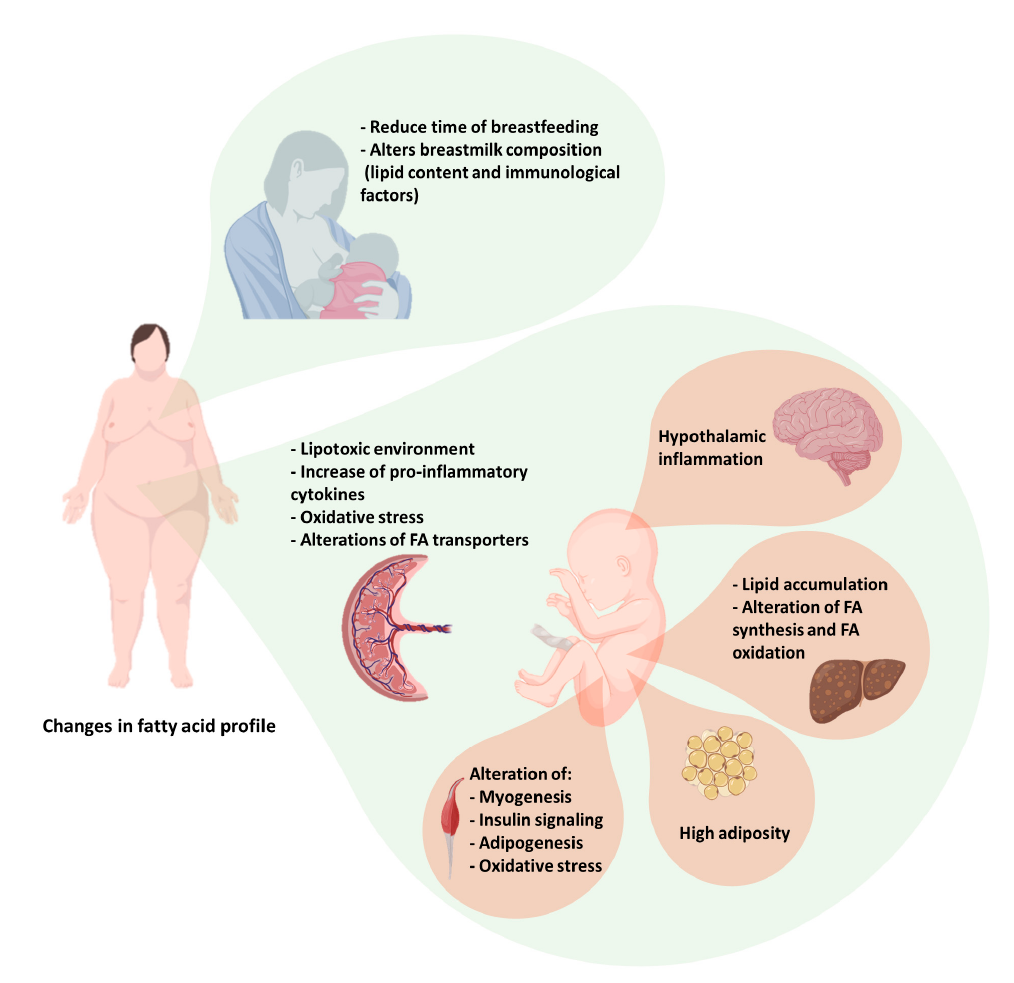
Figure 1. Maternal obesity is associated with changes in circulating fatty acid (FA) profile and placental alterations including a lipotoxic environment, a pro-inflammatory state, and elevated oxidative stress, that altogether lead to modifications in FA transporters that affect the development of fetal organs such as the brain, liver, adipose tissue, and skeletal muscle. Moreover, maternal obesity reduces the time of breastfeeding and alters the FA composition of breast milk.